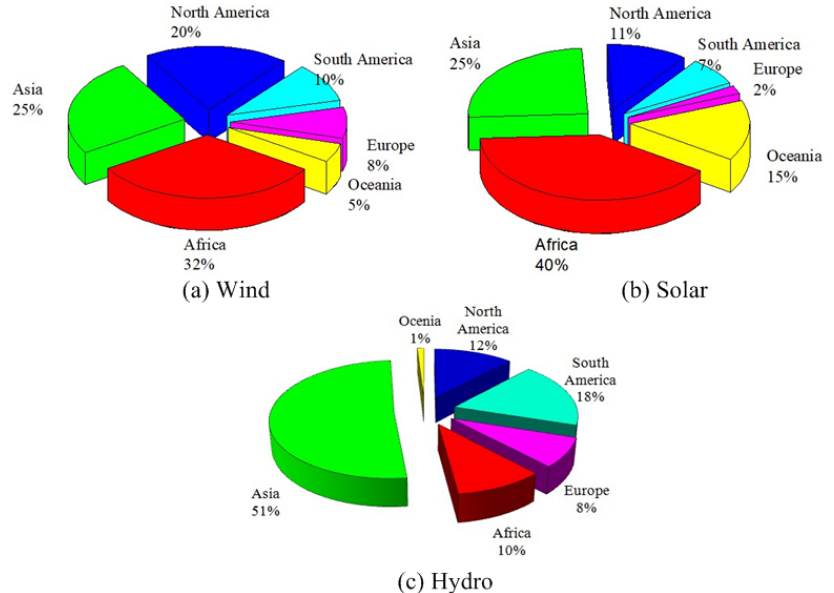
Figure 5. The worldwide distribution of renewable energy sources. ( a ) Wind energy. ( b ) Solar energy. ( c ) Hydro energy [21].